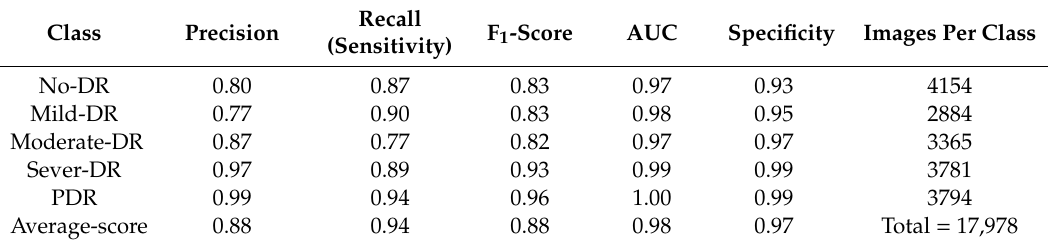
Table 2. Represents the performance of the model on the EyePACS